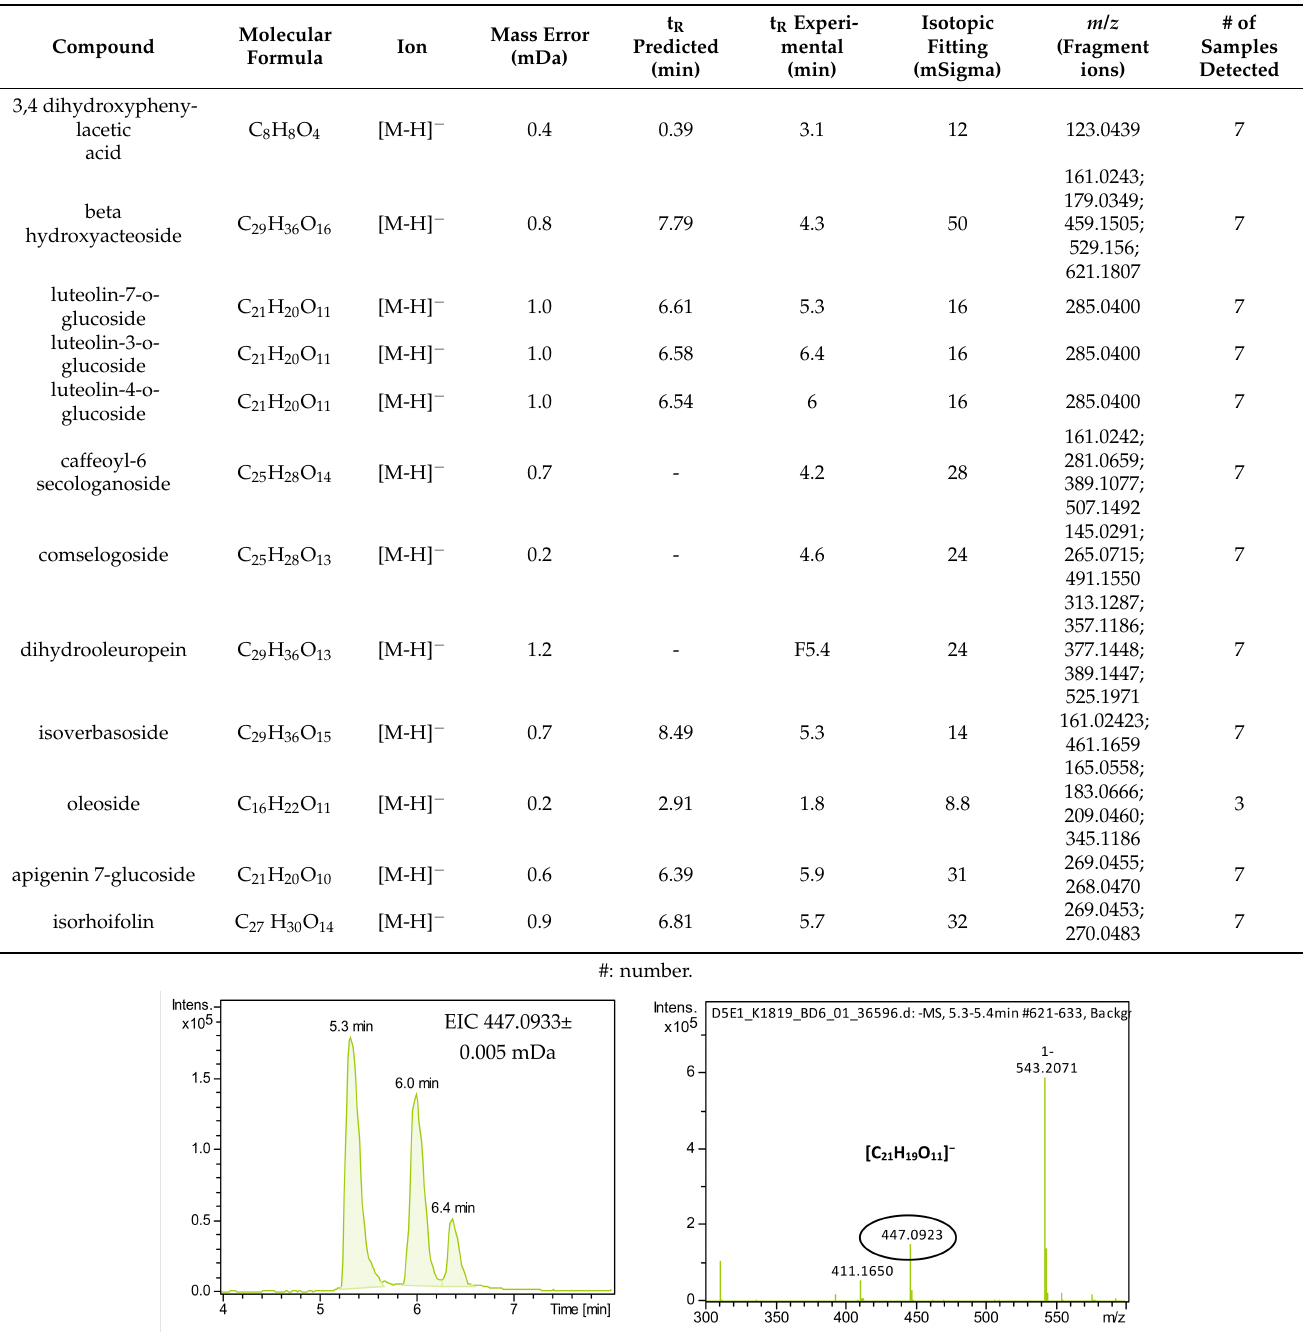
Table 2. Suspect screening results.